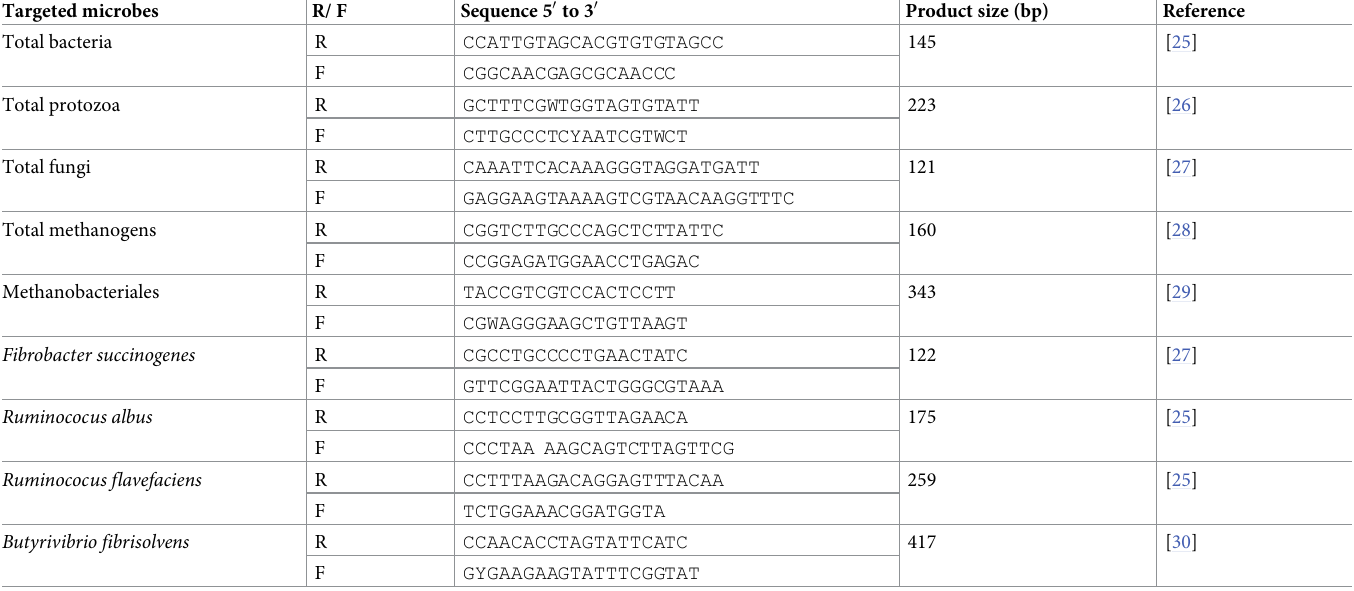
Table 3. Primers used for qPCR